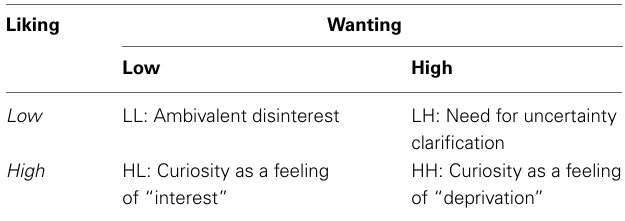
Table 1 | Litman’s classification of curiosity states with respect to high and low levels of liking and wanting (Litman,